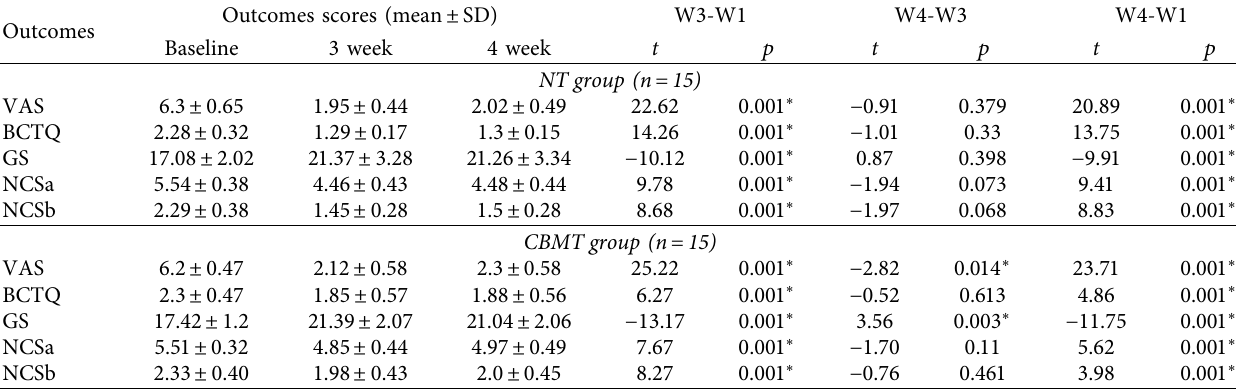
Table 2: Pairwise comparison for the scores of outcomes within groups using paired t -test. Outcomes